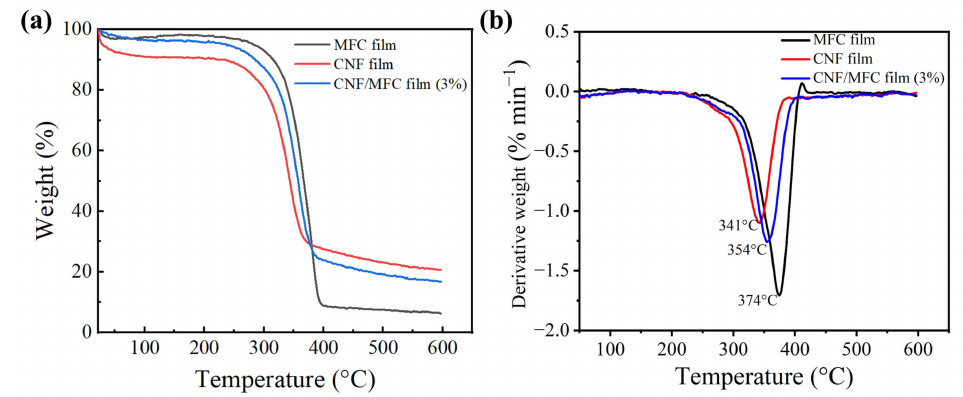
Figure 6. TG ( a ) and DTG ( b ) curves of tunicate cellulose